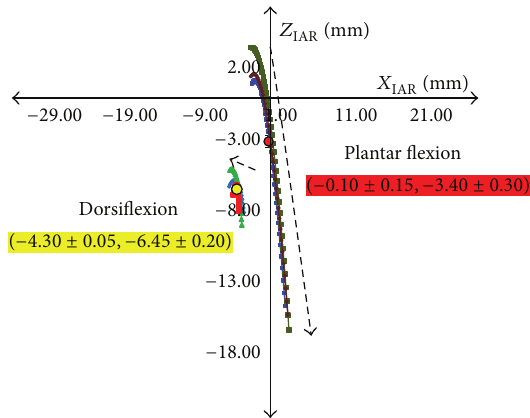
Figure 9: IAR paths of specimen 2 during dorsiflexion and plantar flexion plotted on medial radiographs. Mean IAR values for all three cycles(circles)withstandarddeviations(toosmalltosee)areshown. Dashed arrows denote the direction of the IAR through